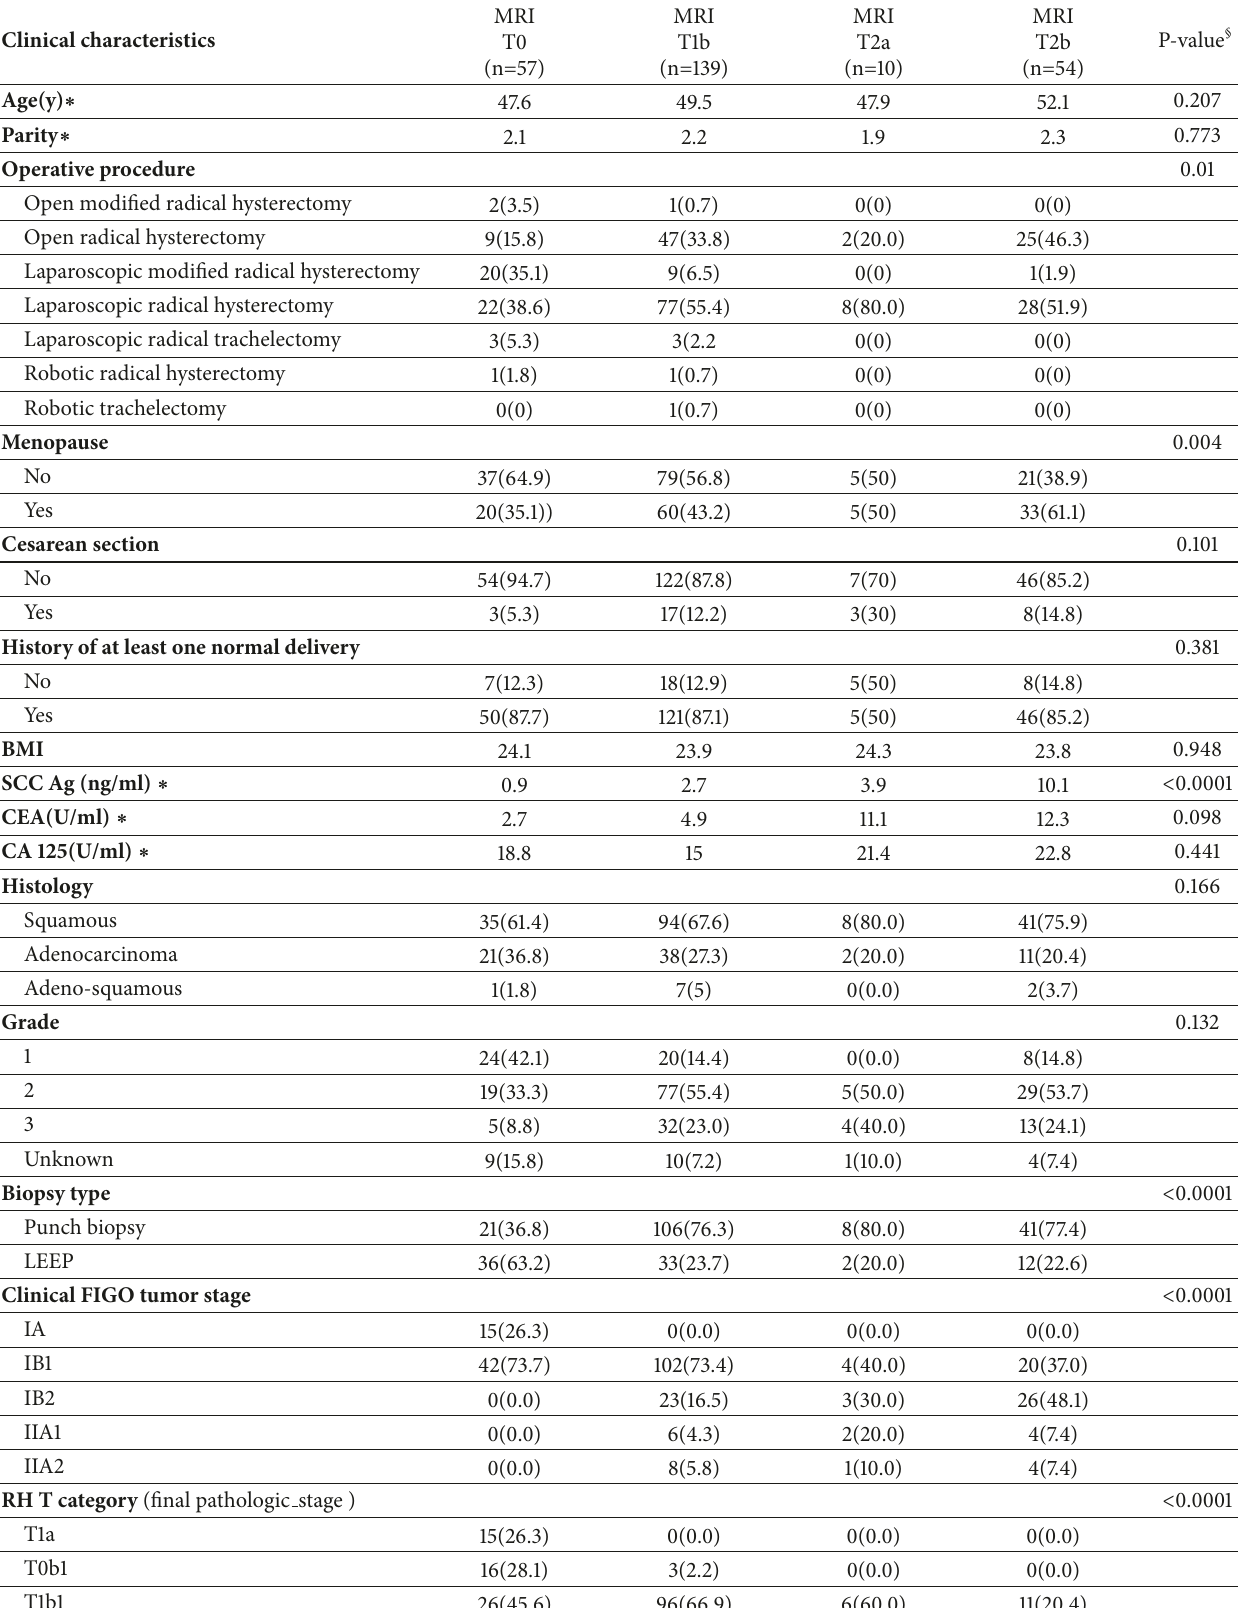
Table 1: Comparison of the distribution of clinical and pathologic characteristics of the 260 women in the cohort study stratified by MRI